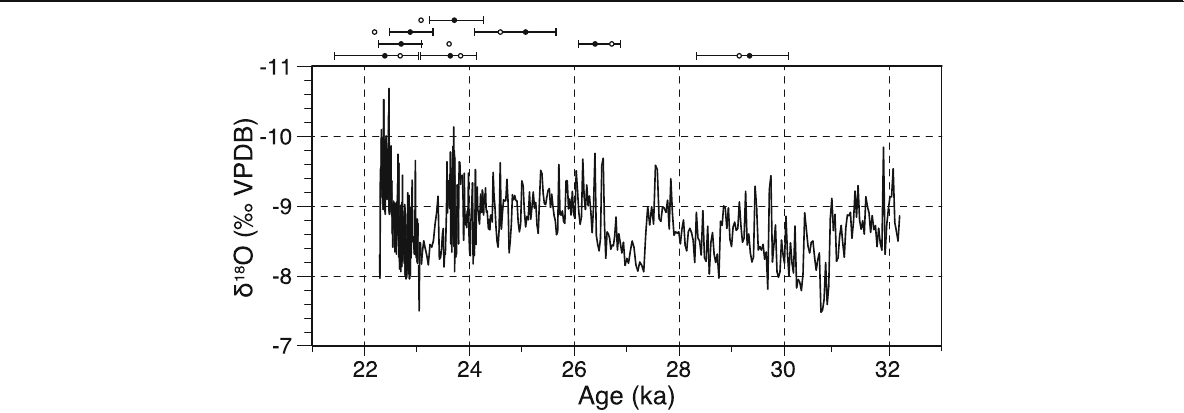
Fig. 3 δ 18 O C age profile of FG02. Note the inverted vertical axis. Dating results are shown at the top; open circles for the corrected 230 Th ages (Table 1), solid circles, and bars for the smoothed ages and the error ranges (Fig. 2), respectively